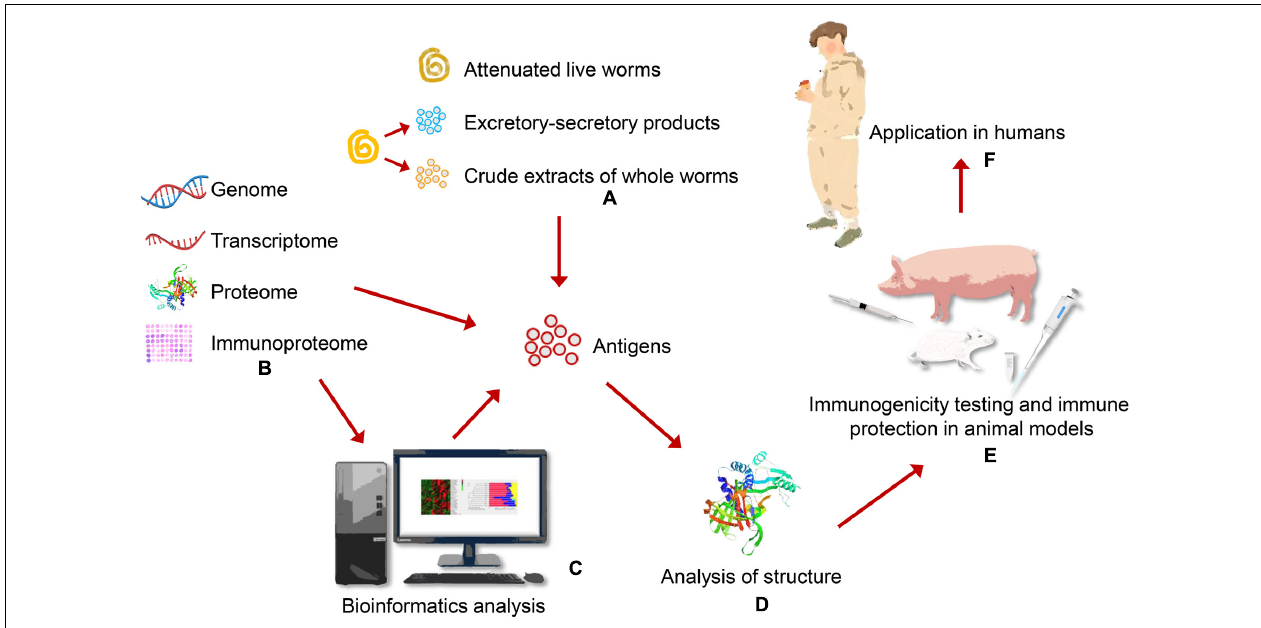
FIGURE 1 | Discovery and identification vaccine candidates through different strategies in animal models. (A) Traditional Trichinella spiralis vaccines are derived from live attenuated vaccines, crude extracts of whole worms, excretory-secretory (ES) products. (B) Vaccine candidates can be screened through different strategies, including genome, transcriptome, proteome, immunoproteome. (C) Candidate antigens are selected for T. spiralis vaccines through bioinformatics analysis. (D) Analyzing structure of antigens contributes to designing effective vaccines in the future. (E) Immunogenicity and immune protection of vaccine candidates are identified through vitro and animal experiments. (F) High effective vaccines translate to meet people need and are applied in